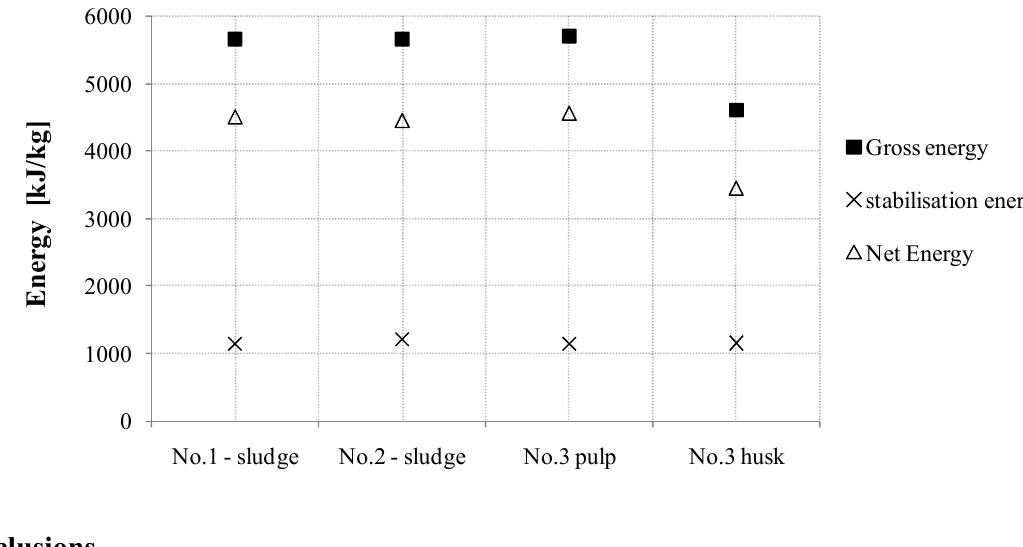
Figure 5. Energy